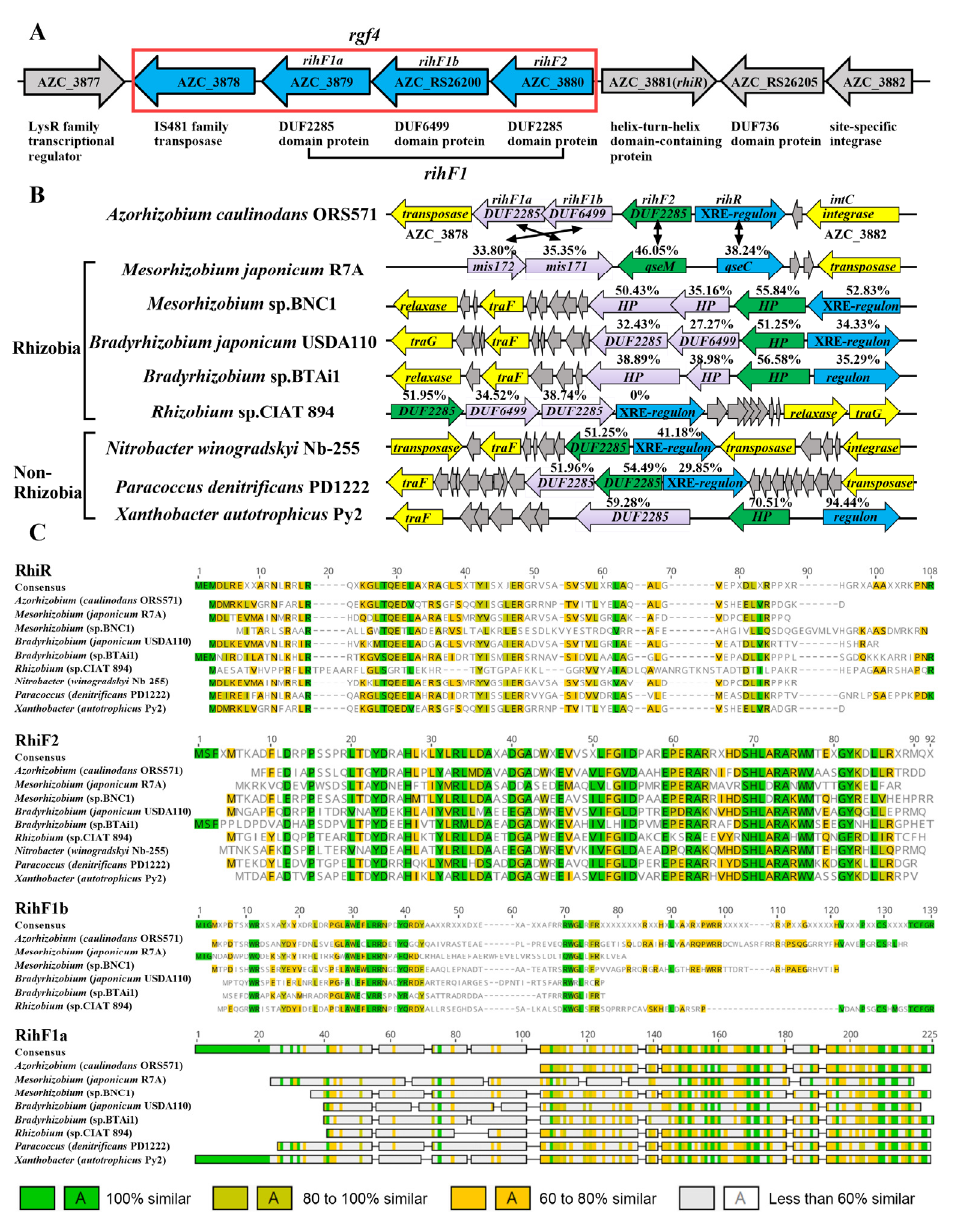
Figure 2. Composition and distribution of rgf4 genes in different strains. ( A ) The genetic structure of rgf4 in A. caulinodans . ( B ) The organization of rgf4 in different strains. Inside of the arrows showed gene function. HP, hypothetical protein. Protein sequence similarity in different strains compared with A. caulinodans is marked above the arrows. ( C ) Multiple sequence alignments of homologous rgf4 from various strains. Higher similarity is indicated by a darker gray backdrop for the amino acid letters.